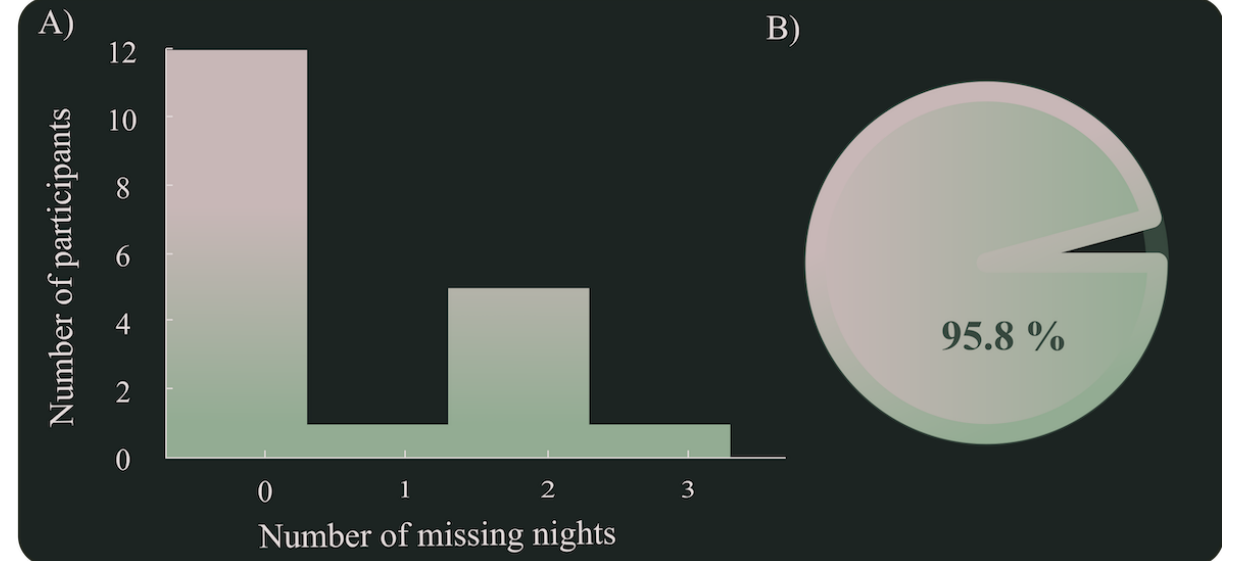
Figure 2. Compliance with wearing the wearable tracking device. A) shows number of missing nights per participant, and B) shows compliance in percentages for all participants during the entire intervention